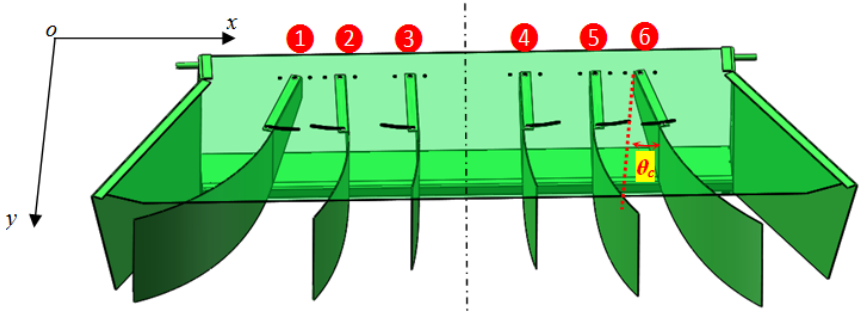
Figure 10. The structure of the throwing device and the installation diagram of the deflector. 1–6 represent the deflectors at different installation positions, 1,6 are the outermost deflectors, and 2–4 are the middle position deflectors.